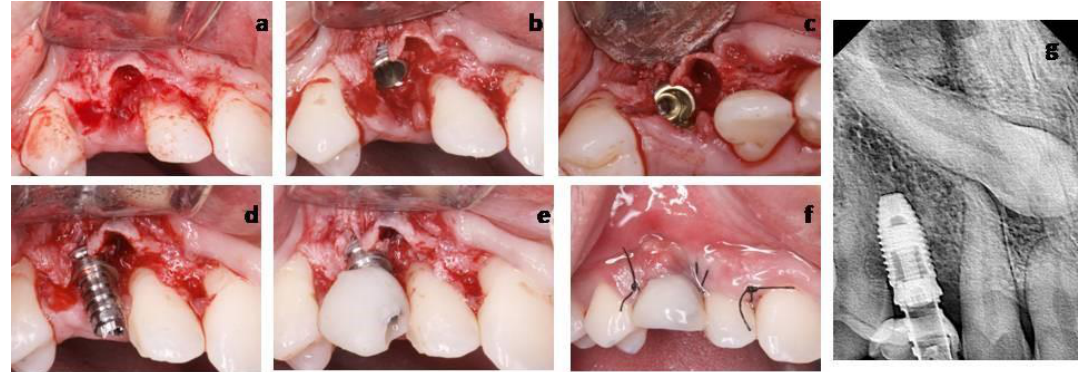
Figure 7. Implant and provisional crown placement (Case 2). ( a ) Abuccal full-thickness flap was raised until the buccal alveolar crest was exposed. ( b ) Inserted implant: Apically from the cementoenamel junction of adjacent teeth. ( c ) Implant occlusal view. ( d ) Implant abutment. ( e ) Provisional screw resin crown. ( f ) Flap was adapted and sutured. ( g ) Periapical radiograph.